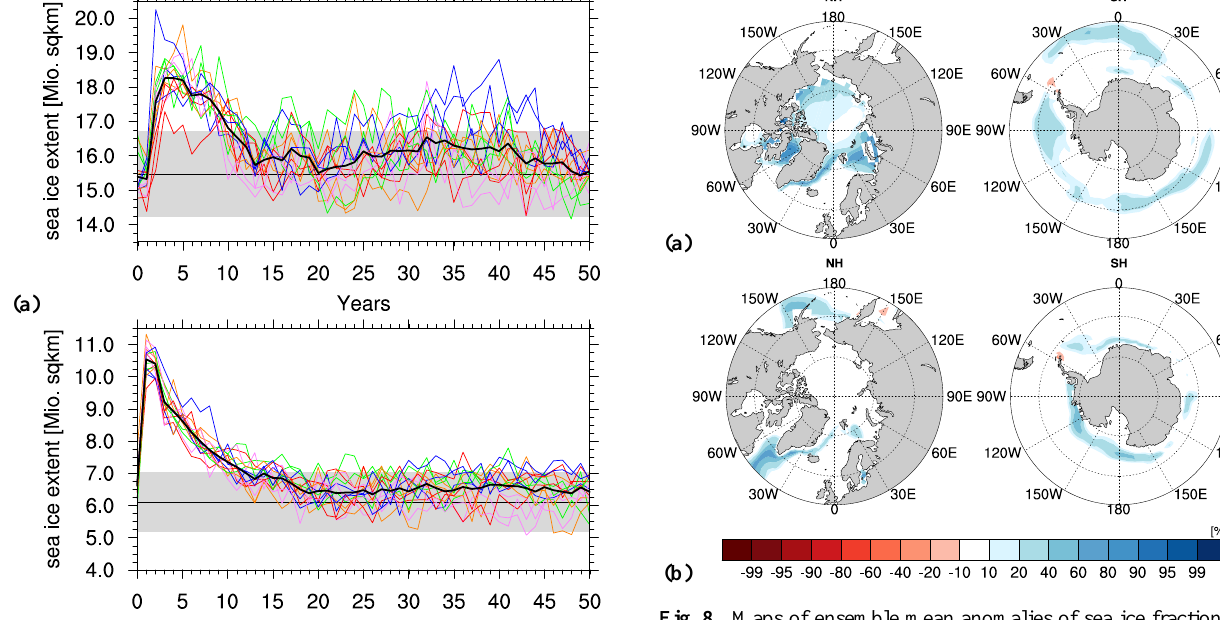
Fig. 8. Maps of ensemble mean anomalies of sea ice fraction [%] for (a) September of year 2 and (b) March of year 3 of the model